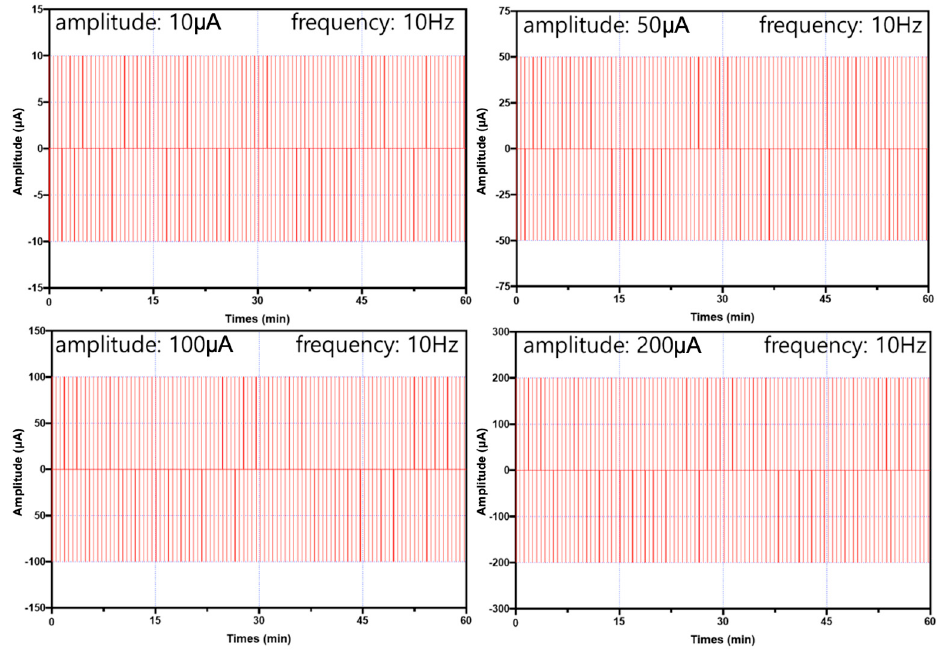
Figure 7. The four different electrical stimulation conditions (experimental group) employed in this study.